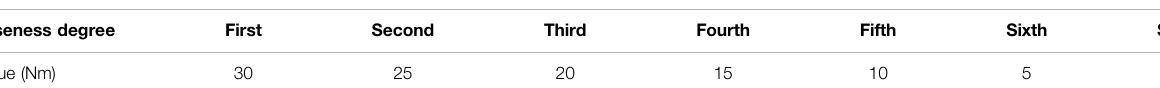
Frontiers in Materials |